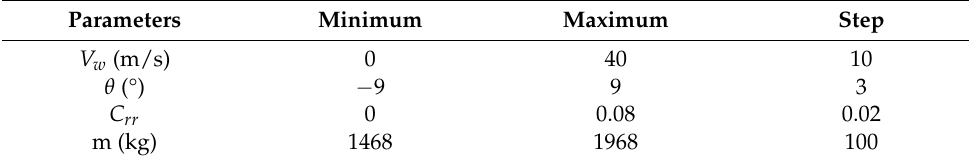
Table 4. Internal and external parameters variation ranges variation.